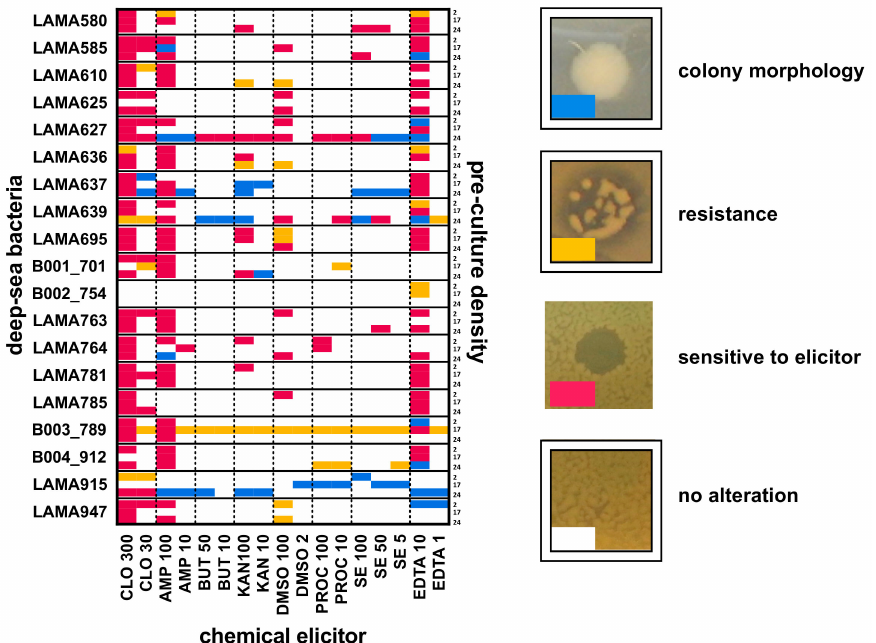
Figure 2. Testing bacterial growth conditions and chemical elicitors in solid media reveals alterations in colony morphology, indicating the modulation of bacterial metabolism. Graphical representation of morphological changes in bacterial growth in solid media induced by the different chemical elicitors, in different growth conditions. Each row represents a bacterial strain at a given preculture density (2, 17 or 24 h—strain sub-rows). Each column represents a chemical elicitor. The classification scheme adopted for annotating the morphological changes produced by chemical elicitors is represented by different colors: no changes (white); halo formation, sensitive to elicitor (magenta); bacterial growth inside the halo, microbial resistance (yellow); changes in colony morphology (blue).